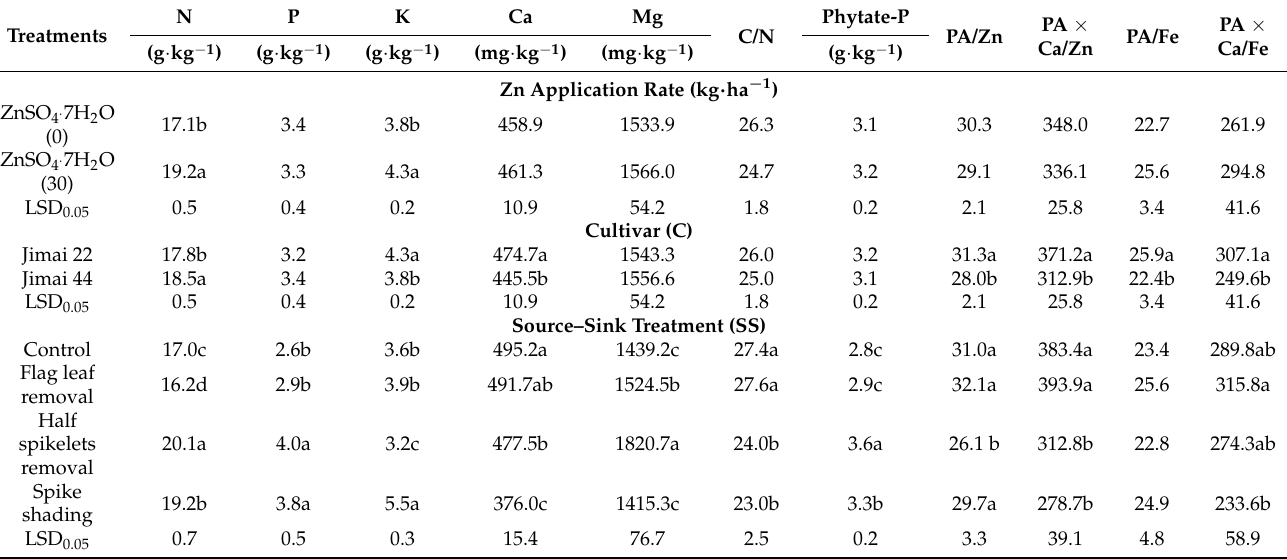
Values followed by different lowercase letters in the same column are significantly different among treatments at p ≤ 0.05. Values under ANOVA are probabilities ( p values) of the source of variation. There were no significant impacts of soil Zn application or cultivars on grain Zn, Fe, Mn and Cu yields (Table S3). For source–sink treatments, grain Zn, Fe, Mn and Cu yields were all decreased compared with the control. The grain Mn yields in spike shading and Cu yields in half spikelet removal were most significantly reduced. The interaction of cultivars × source–sink manipulations significantly affected grain Zn and Mn yields (Table S3). 2.3. Concentrations and Yields of N, P, K, Ca, Mg and Phytate-P, C/N Ratios, and Molar Ratios of PA/Zn, PA/Fe, PA × Ca/Zn and PA × Ca/Fe in Wheat Grains N and K concentrations from 17.1 to 19.2 g · kg − 1 , and from 3.8 to 4.3 g · kg − 1 , respectively (Table 3). Similar results were found in grain N and K yields (Table S3). Variation in Zn supply had non-significant impacts on other nutritional traits in wheat grains. Jimai 44, as a high-quality strong gluten wheat cultivar, had significantly higher grain N concentration, and significantly lower grain K and Ca concentrations, grain N, K, Ca, Mg and phytate-P yields, and molar ratios of PA/Zn, PA/Fe, PA × Ca/Zn and PA × Ca/Fe than those of the high-yielding Jimai 22 (Table 3 and Table S3). Table 3. Effects of soil Zn application and source–sink manipulations on concentrations of N, P, K, Ca, Mg and phytate-P, C/N ratios, and molar ratios of PA/Zn, PA × Ca/Zn, PA/Fe and PA × Ca/Fe in grains of different wheat cultivars. Treatments